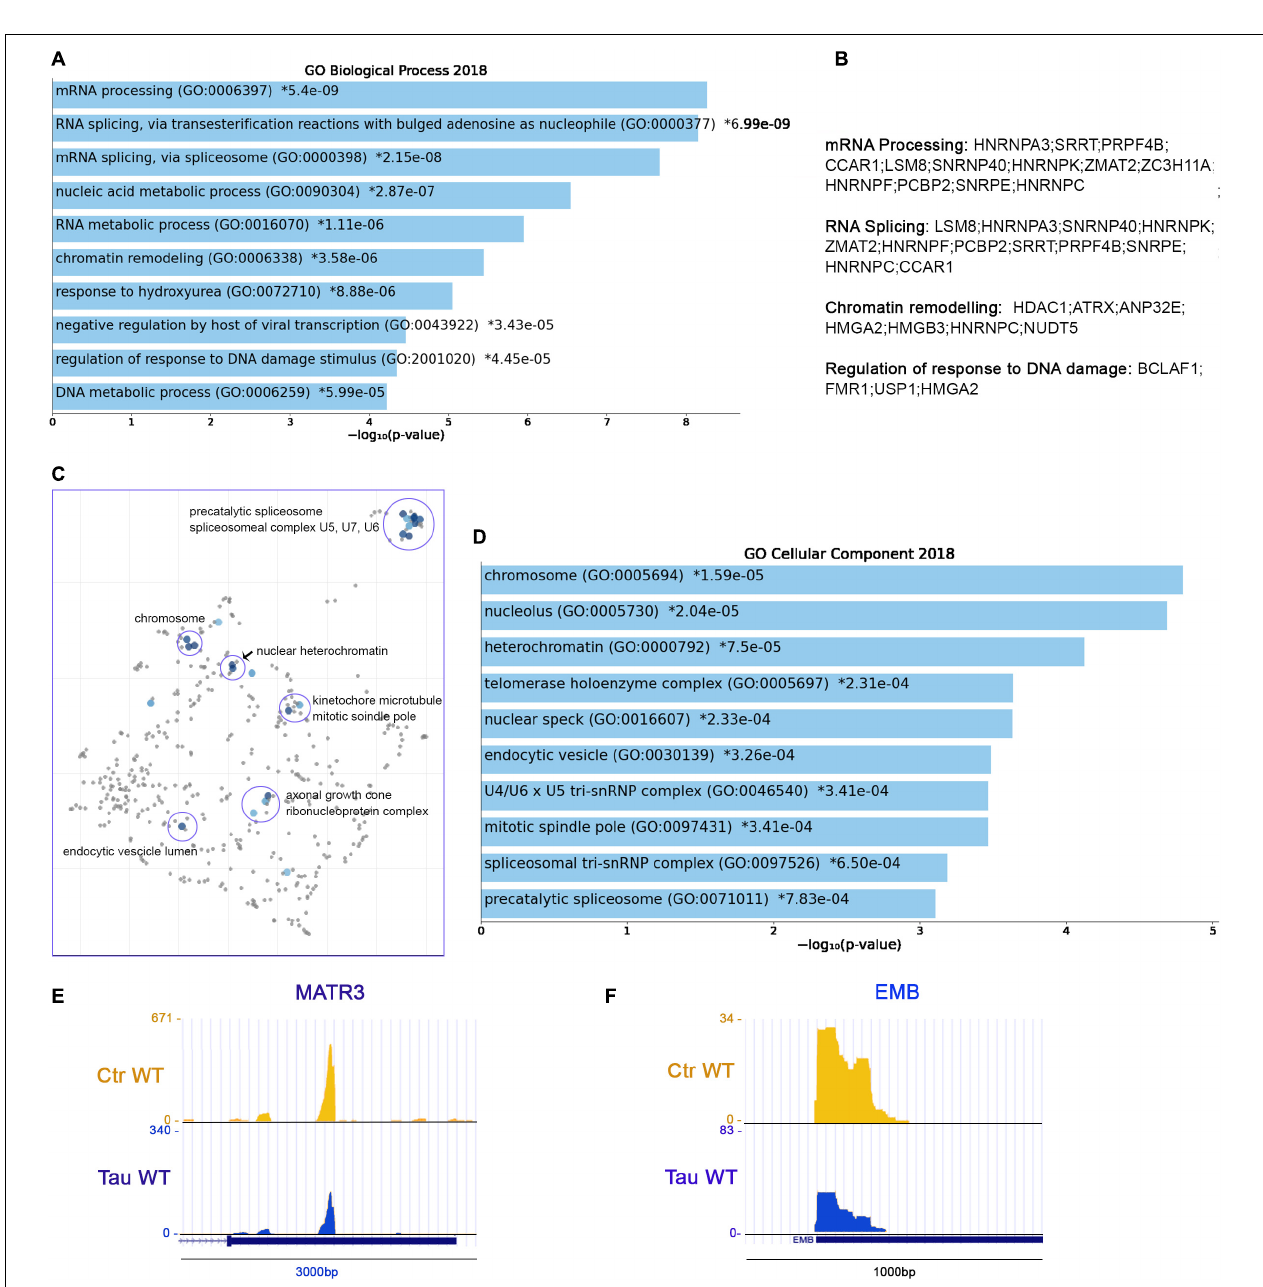
FIGURE 5 | RNA metabolism, chromatin organization and HNRNP s precursor’s display shortened APAs in the presence of WT tau. (A) Enrich-GO Biological Process of WT tau shortened APAs ( p -value reported). (B) Partial list of biological process genes with shortened APAs upon presence of WT tau (mRNA processing, RNA splicing, chromatin remodeling and regulation of response to DNA damage). (C) The Cellular Components scatterplot is organized so that similar gene sets are clustered together. The larger blue points represent significantly enriched terms—the darker the blue, the more significant the term and the smaller the p -value. The gray points are not significant. Plots has been generated and downloaded using scatter plot visualization Appyter. (D) Enrich-GO Cellular Component of WT tau shortened APAs ( p -value reported). Representative poly-A site usage for shortened poly-A tails from PAC-Seq of MATR3 (E) and EMB (F) transcripts. An asterisk (*) next to a p -value indicates the term also has a significant adjusted p -value ( <